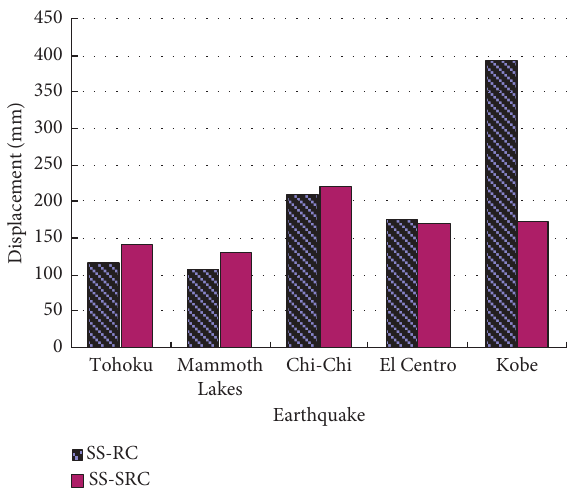
Figure 18: Maximum resultant displacements of the latticed shells.